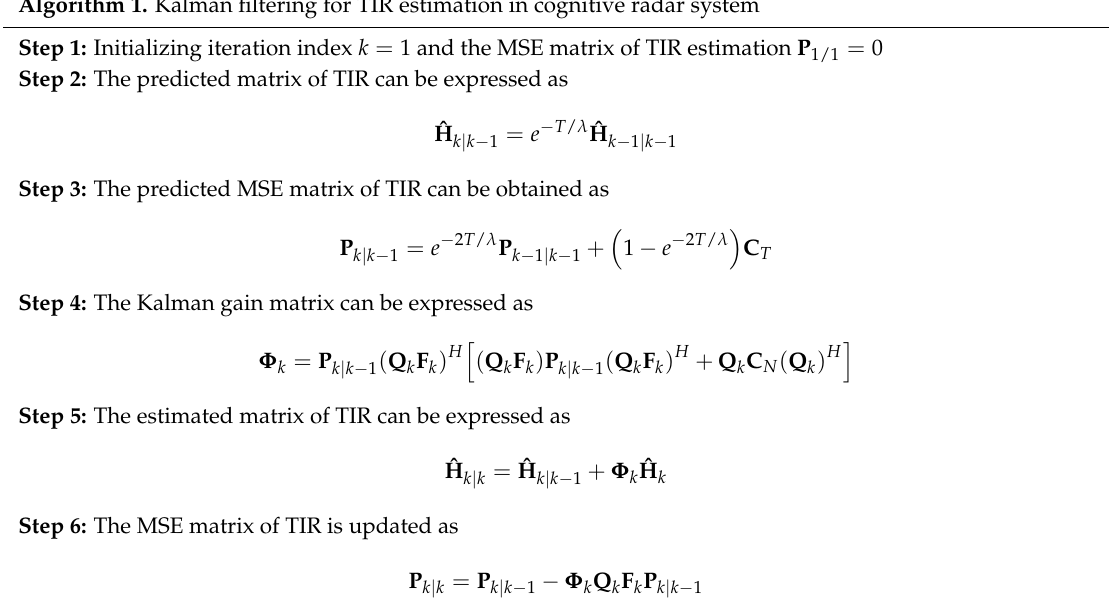
Algorithm 1. Kalman filtering for TIR estimation in cognitive radar